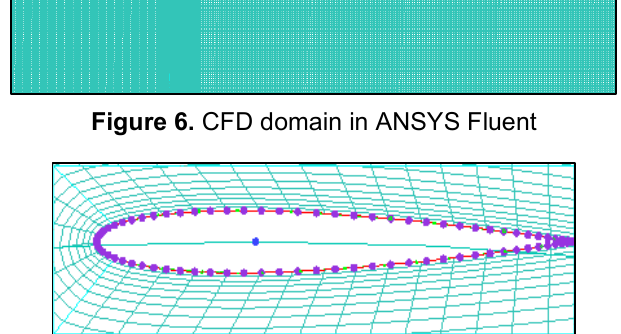
Figure 7. Close view of the